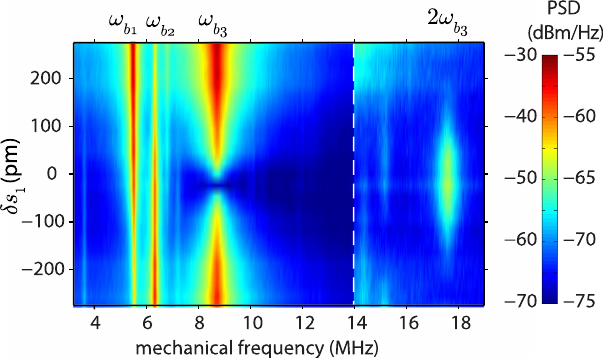
FIG. 6. rf photocurrent noise spectrum for the optically trans- mitted light past the double-slotted photonic crystal cavity. Here, the applied voltage V 2 ¼ 1 V is held fixed and V 1 is swept from just below to just above the anticrossing point of Fig. 4(a). In these measurements the probe laser power is 10 μ W at the input to the cavity, the probe laser frequency is set on the blue side of ffiffiffi p ≈ κ = 2 3 the upper frequency supermode resonance, Δ , and the L fiber taper is placed in the near field of the photonic crystal cavity resulting in an on-resonance dip in transmission of approximately Δ T ¼ 15% . The vertical axis in this plot is converted to a change in the slot width δ s 1 using the numerically simulated value of α ¼ 0 . 025 nm = V 2 . The color indicates the magnitude of the rf cap noise power spectral density (PSD) in dBm = Hz, where the color scale from 0 to 14 MHz is shown on the left of the scale bar and the color scale from 14 to 20 MHz is shown on the right of the scale bar (a different scale is used to highlight the noise out at 2 ω b 3